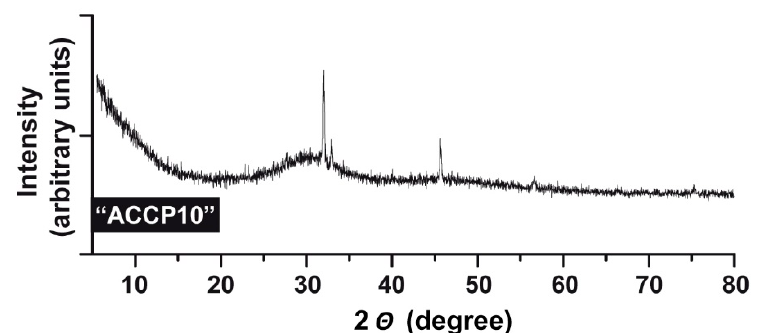
Figure 2. X-ray diffraction analysis. The XRD pattern was obtained from ACC particles stabilized with 10% ( w/w ) Na–polyP, “ACCP10”. The NaCl signals highlight as sharp spikes.